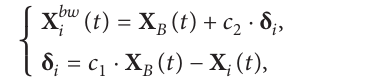
Figure 7: Structure of the